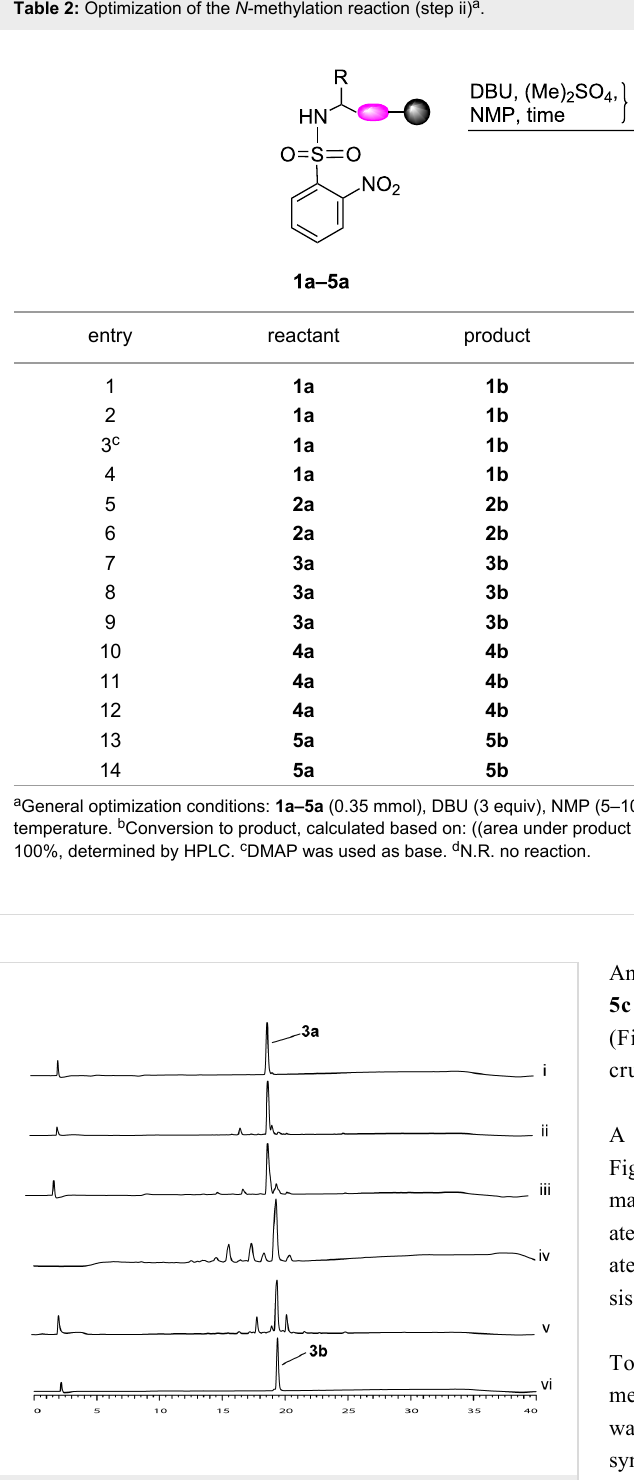
Figure 5: Methylation of motif 3a to 3b using various reaction condi- tions. HPLC trace overlay presents the effect of different reaction conditions on the conversion yield. HPLC trace of i) purified motif 3a . ii) crude motif 3a . vi) purified methylated product 3b . N